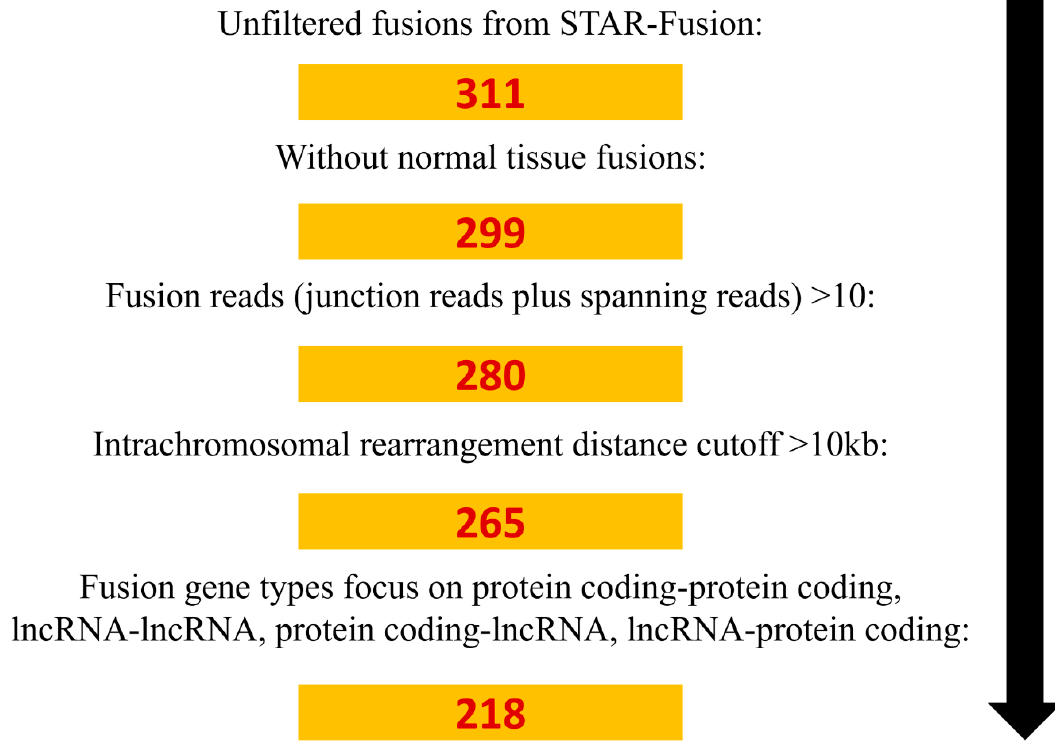
Figure 1. Overview of the filtering process of fusion gene RNA-Seq reads obtained from NSCLC (non-small cell lung cancer) samples.